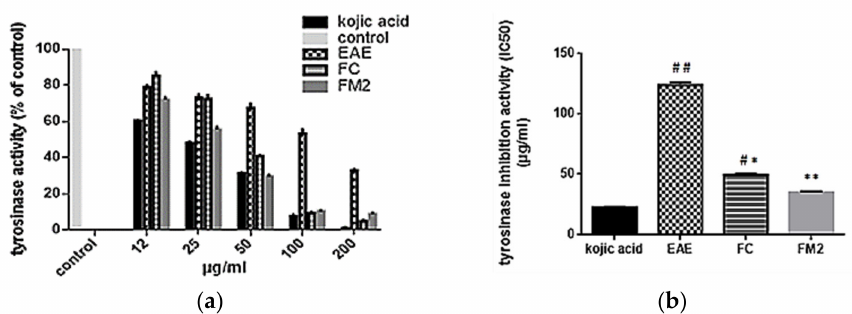
Figure 6. ( a ) Tyrosinase activity (% of control) and ( b ) tyrosinase mushroom inhibition activity (IC 50 ) of ethyl acetate extract (EAE), quercetin-3- O -rhamnoside (FC), myricetin-3- O -rhamnoside (FM2), and kojic acid (standard). (Bars, ± SD ( n = 3)), * significant p < 0.001 and ** significant p < 0.0001 compared to EAE, # significant p < 0.001 and ## significant p < 0.0001 compared to kojic